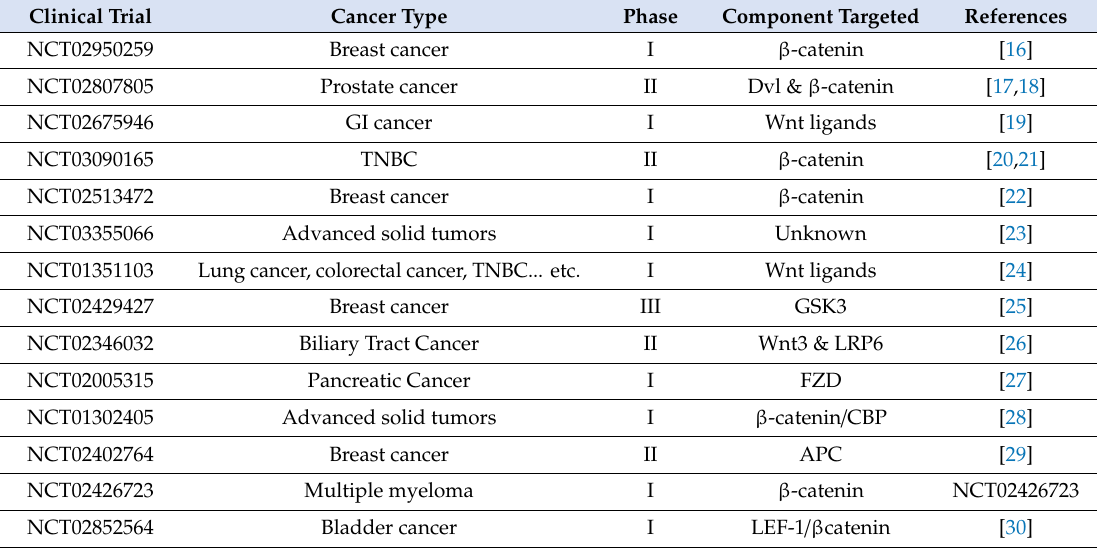
Table 1. Clinical trials using drugs that are known to reduce Wingless (Wnt)